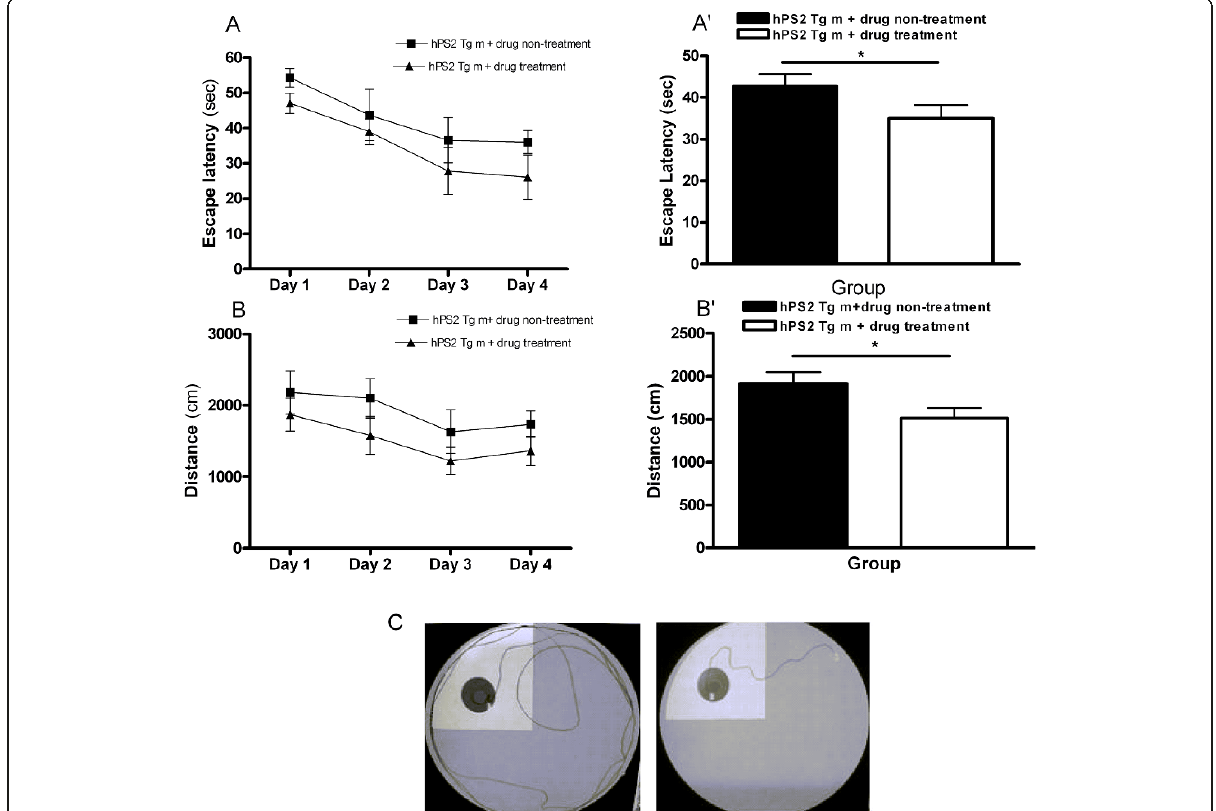
Figure 2 Alteration of escape latency and swimming distance during an acquisition test using the water maze . Four trials per day for 4 consecutive days were conducted and the escape latency ( A and A ’ ) and swimming distance ( B and B ’ ) were measured. Representative images (C) showing the swimming path of mice during the tests. Left: drug non treated- hPS2 transgenic mice and right: drug treated-hPS2 transgenic mice. Data are presented as mean ± SEM, and comparisons between the two groups were evaluated by the unpaired t -test. * P < 0.05 compared to the drug treated-hPS2 transgenic